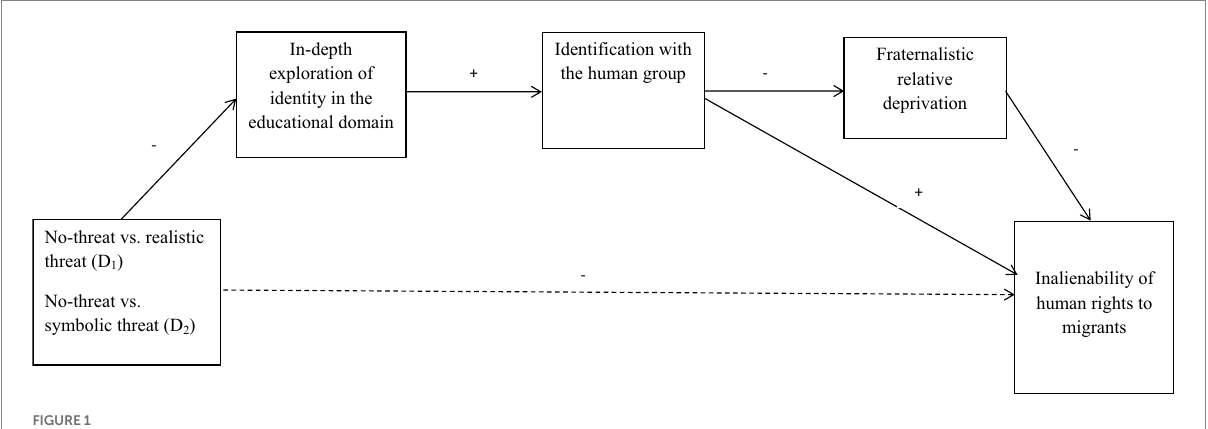
FIGURE 1 Conceptual multiple step mediation model of the effect of intergroup threat (dummy coded as D 1 and D 2 ) on inalienability of human rights to migrants through in-depth exploration of identity in the educational domain, identification with the human group, and fraternalistic relative deprivation. D 1 , no-threat (0), realistic threat (1); D2, no-threat (0), symbolic threat (1).